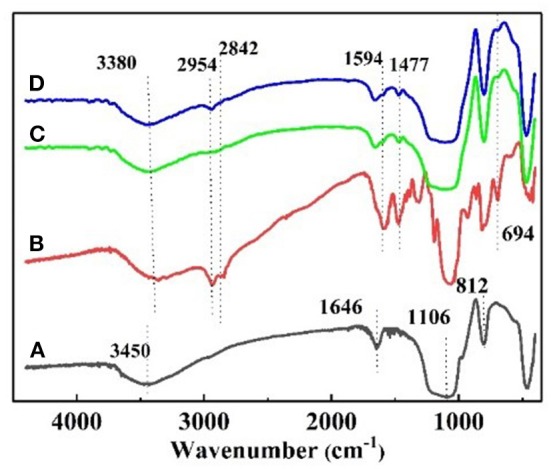
(A) FT–IR spectra of raw SiO2, (B) KH540, (C) NS–NH2, and (D) NS–NR2.